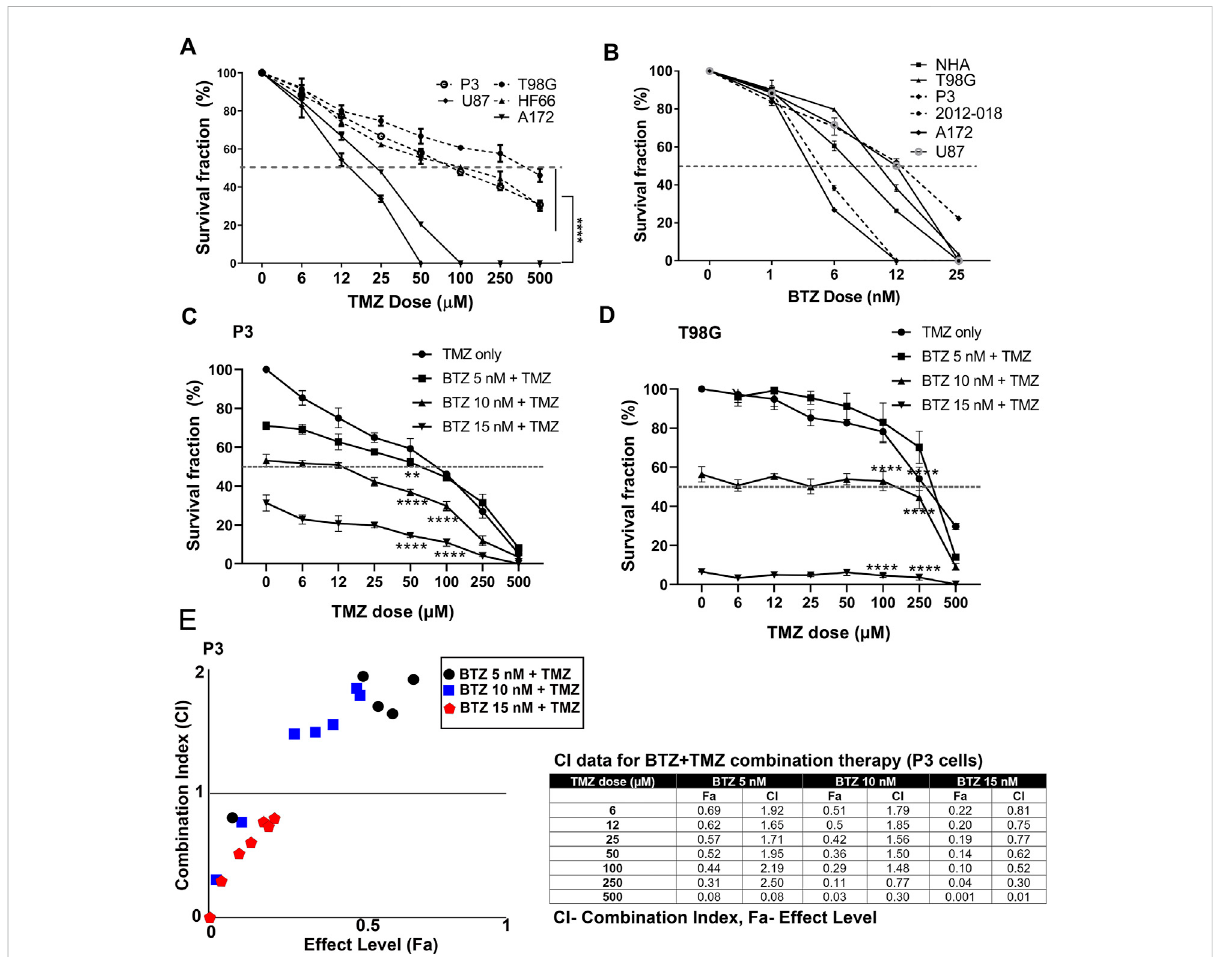
FIGURE 1 BTZ pre-treatment synergizes with TMZ treatment and chemosensitizes GBM cells (A) Mean % ± S.E.M clonogenic survival of tumour cells treated with TMZ for 72 h (B) Mean % ± S.E.M clonogenic survival of tumour cells and normal human astrocytes (NHA) treated with BTZ for 48h. Clonogenicsurvivingfractionsof (C) P3and (D) T98Gtumourcellsafterspeci fi edtreatments,BTZconcentrationwas0,5,10and15 nM,respectively, and TMZ concentration in 6 – 500 μ M range. (E) Combination index plot (left) and data table (right) from report generated by Compusyn software for drug combination synergy calculation following the Chou-Talalay method of P3 cells treated with BTZ 5, 10, and 15 nM and TMZ concentration in6 – 500 μ Mrange. Combination index(CI) quantitativelydetermine “ Synergism(CI < 1), additive-effect (CI = 1)and antagonism (CI > 1). Each experiment was performed in triplicate, and data represents the mean ± S.E.M of at least 3 independent experiments, ** p < .01 and **** p <